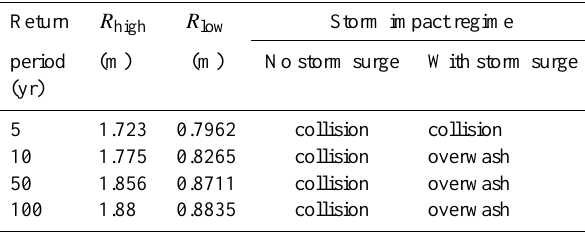
Table 6. Storm impact regimes corresponding to the 5-, 10-, 50-, and 100-year return values of R high and R low , considering a value of D high and D low of 2.27 and 0.8m, respectively, and a typical value of storm surge ( ≈